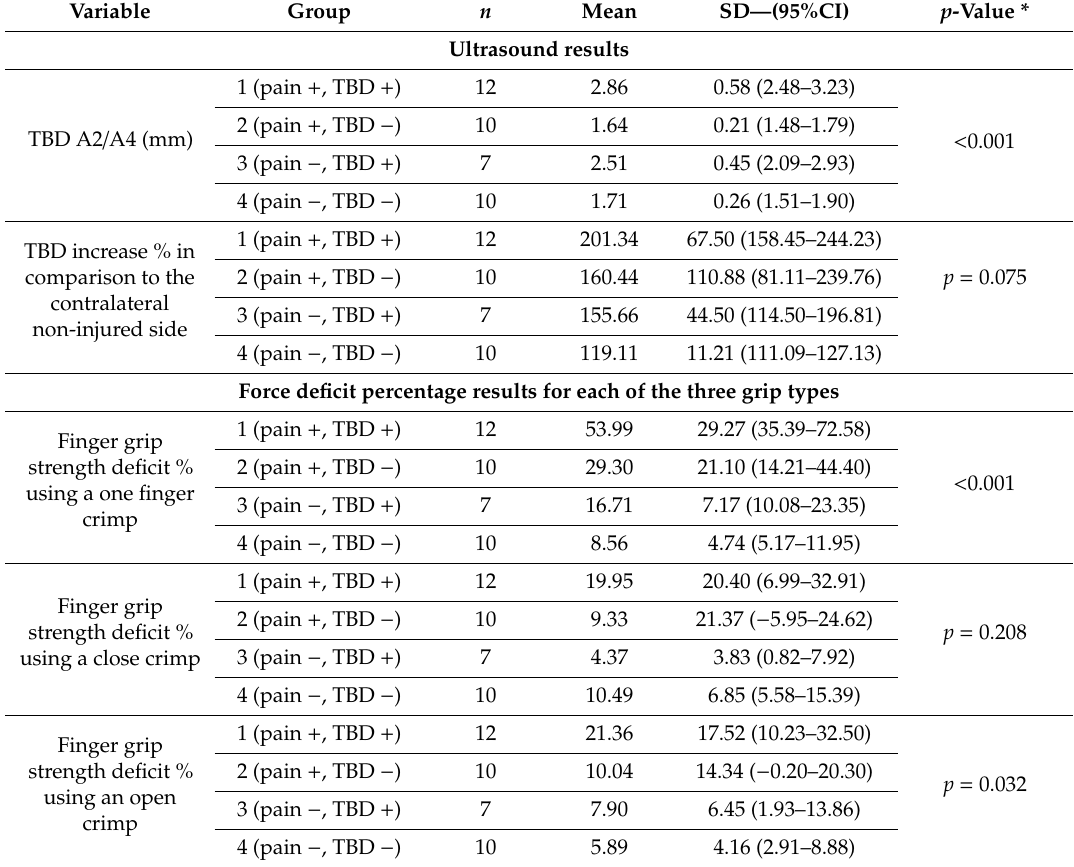
Table 2. TBD and finger grip strength deficit